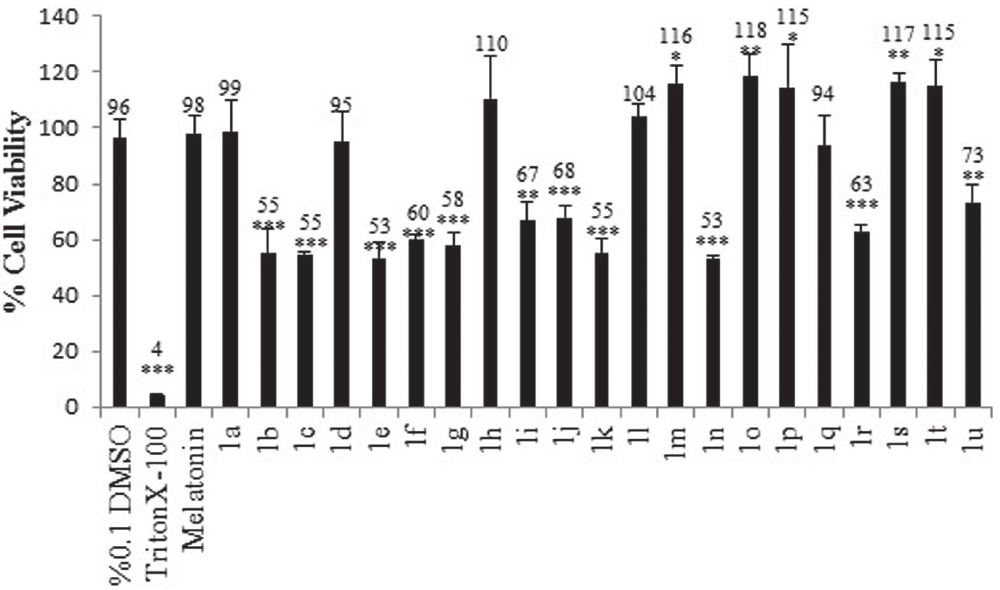
FIGURE 3 - Effects of novel compounds on cell viability in CHO cells. Bars represent the “% cell viability mean ± standart deviation” values from 3 separate experiments for each molecule. % Viability evaluation was calculated according to solvent control (DMSO 0.1%). Triton X-100 was used as a positive control. Statistical significance was expressed as * p <0,05; ** p <0.01; *** p